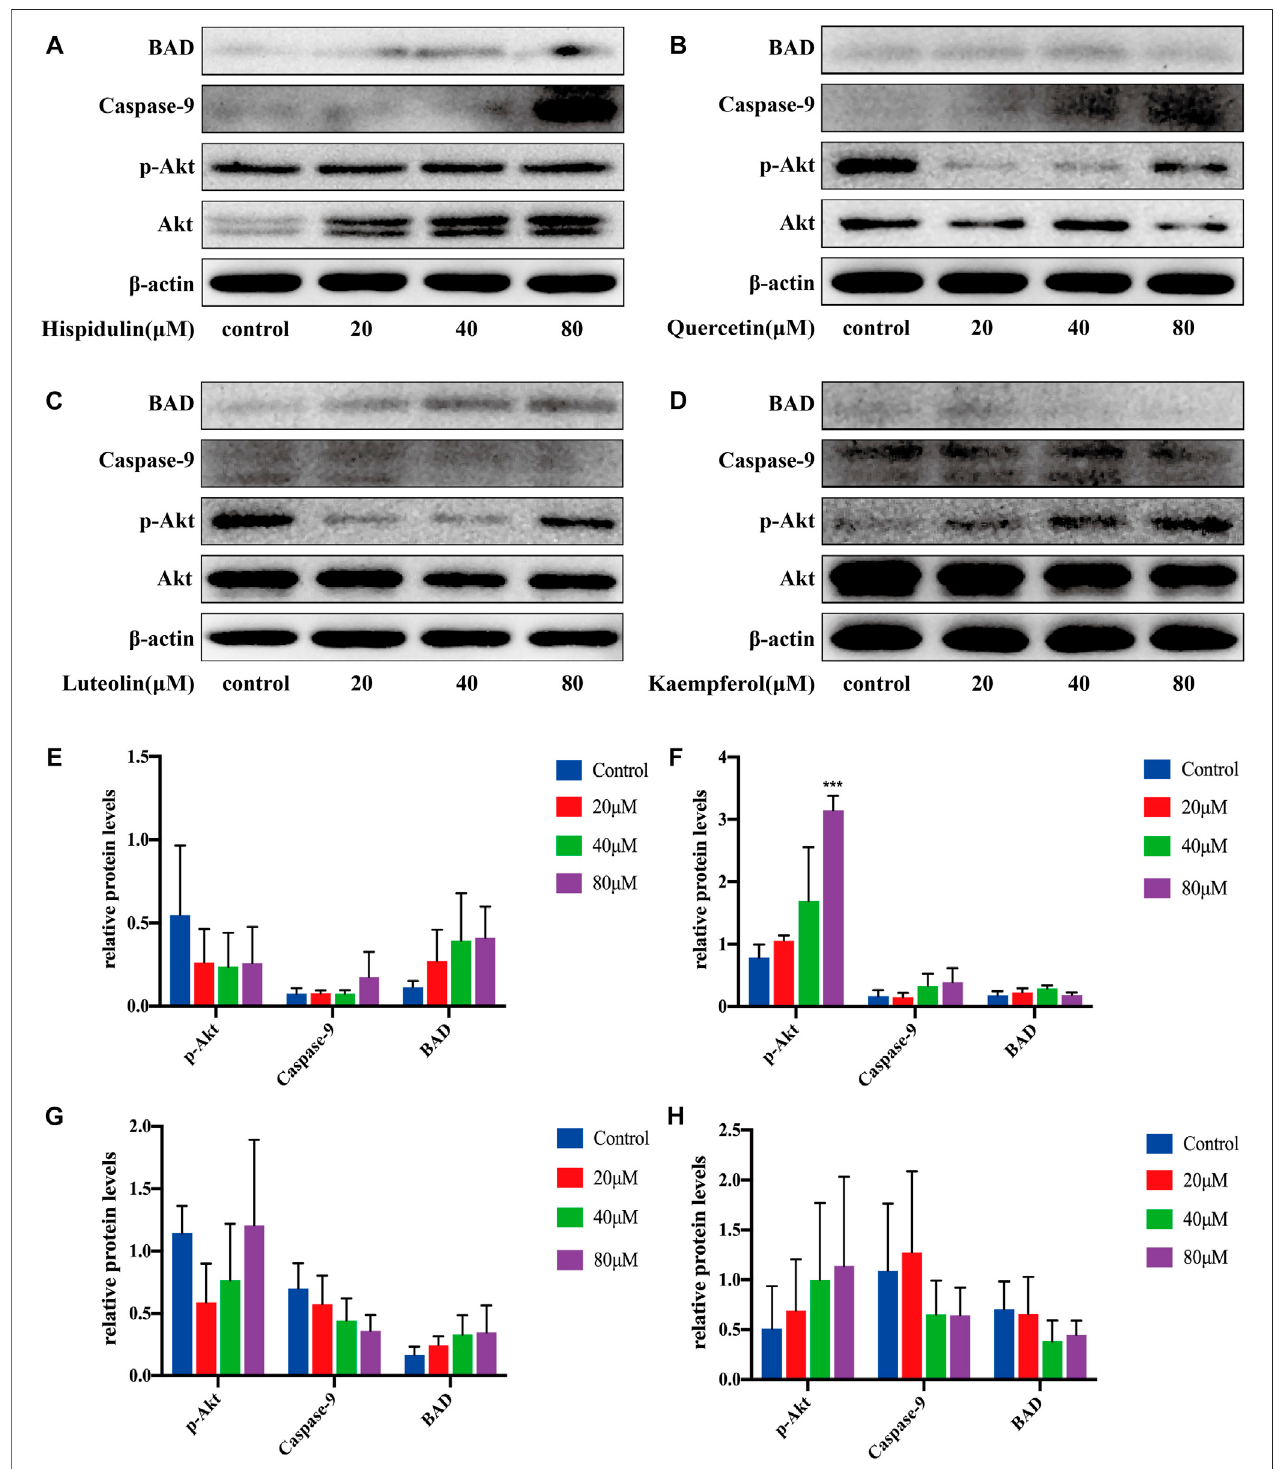
FIGURE 8 | Western blot analysis of Akt, p-Akt, caspase-9, and BAD expressions in A549 cells. (A) Cells were treated with or without hispidulin (0, 20, 40, or 80 μ M)for24 h. (B) Cellsweretreatedwithorwithoutquercetin(0,20,40,or80 μ M)for24 h. (C) Cellsweretreatedwithorwithoutluteolin(0,20,40,or80 μ M)for24 h. (D) Cellsweretreatedwithorwithoutkaempferol(0,20,40,or80 μ M)for24 h. (E) Quanti fi cationdataofwesternblotingroupA. (F) Quanti fi cationdataofwesternblotin groupB. (G) Quanti fi cationdataofwesternblotingroupC. (H) Quanti fi cationdataofwesternblotingroupD.Experimental valuesareexpressed asmean ± SDfor each group ( n (cid:2) 3, *** p < 0.001 with the control group).